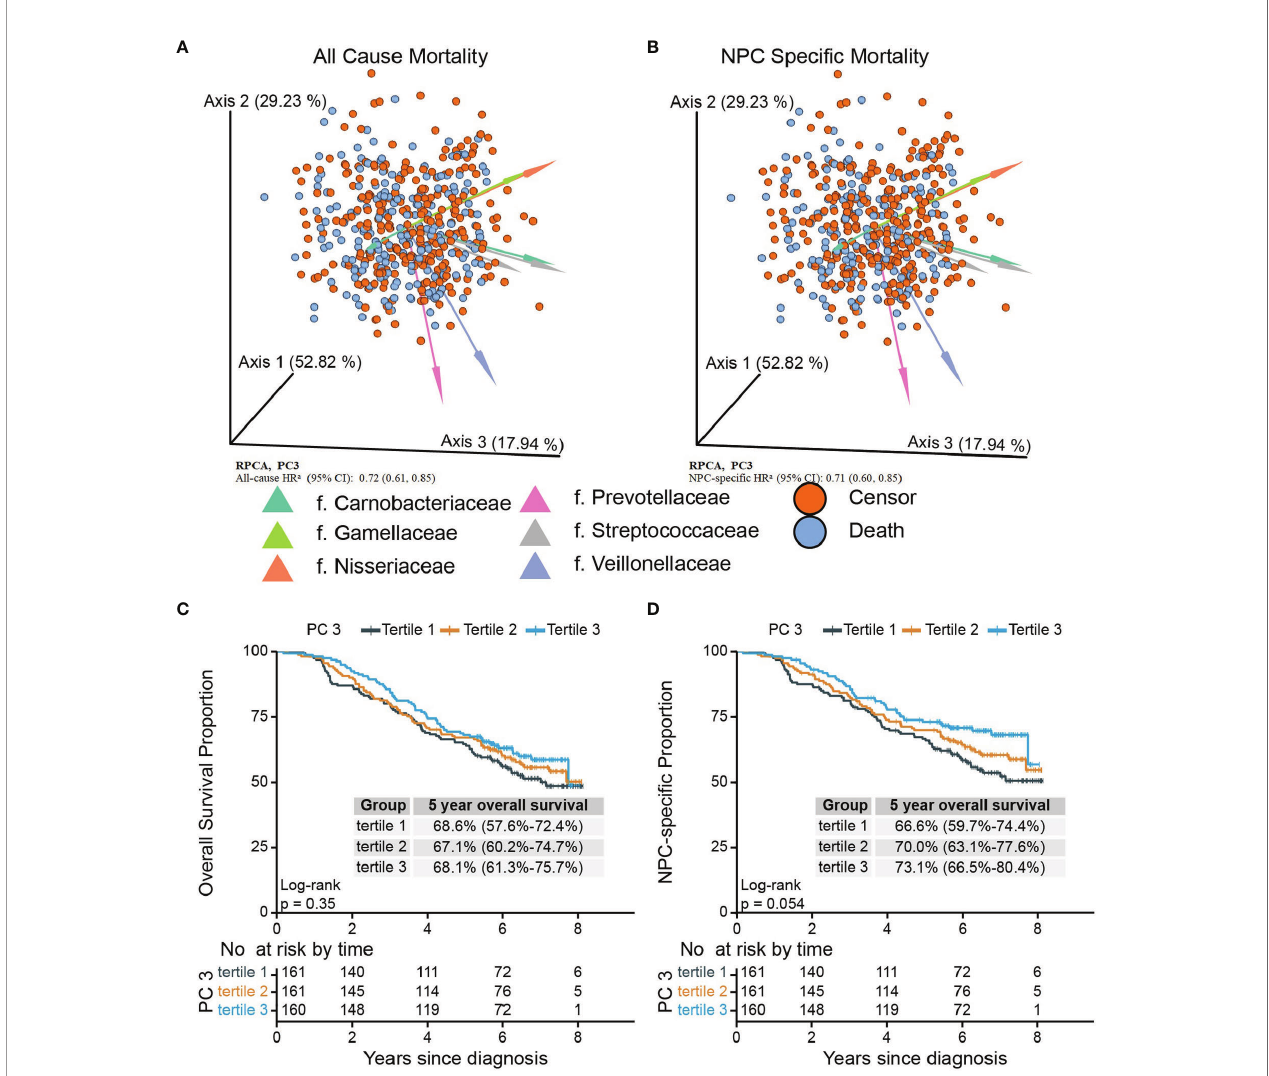
FIGURE 2 | Biplots of RPCA by survival status (A) and NPC-speci fi c survival status (B) and Kaplan – Meier curves of overall (C) and NPC-speci fi c survival (D) proportion between tertiled PC3 groups generated from RPCA. PC3 of RPCA were signi fi cant mortality predictor (A, B) in Cox model with all-cause HR of 0.72 (95% CI, 0.61 – 0.85) and NPC-speci fi c HR of 0.71 (95% CI, 0.60 – 0.85). Arrows in (A) and (B) were top 8 taxa in fl uencing the principal component axis. Axis1, axis2, and axis3 were equal to PC1, PC2, and PC3. The axes were labeled with the variation proportion that PCs explain. Sample loadings PC3 were z-normalized in Cox models. a HRs were adjusted for age at diagnosis, sex, sequencing running number, tobacco use, the number of missing or fi lled tooth, cancer stage, treatment pattern, saliva sampling season, BMI before treatments, alcohol use, diagnosis calendar year, and residential community and Faith ’ s PD. PC3 were z-normalized. RPCA, robust Aitchison principal-component analysis; NPC, nasopharyngeal carcinoma; Faith ’ s PD, Faith ’ s phylogenetic